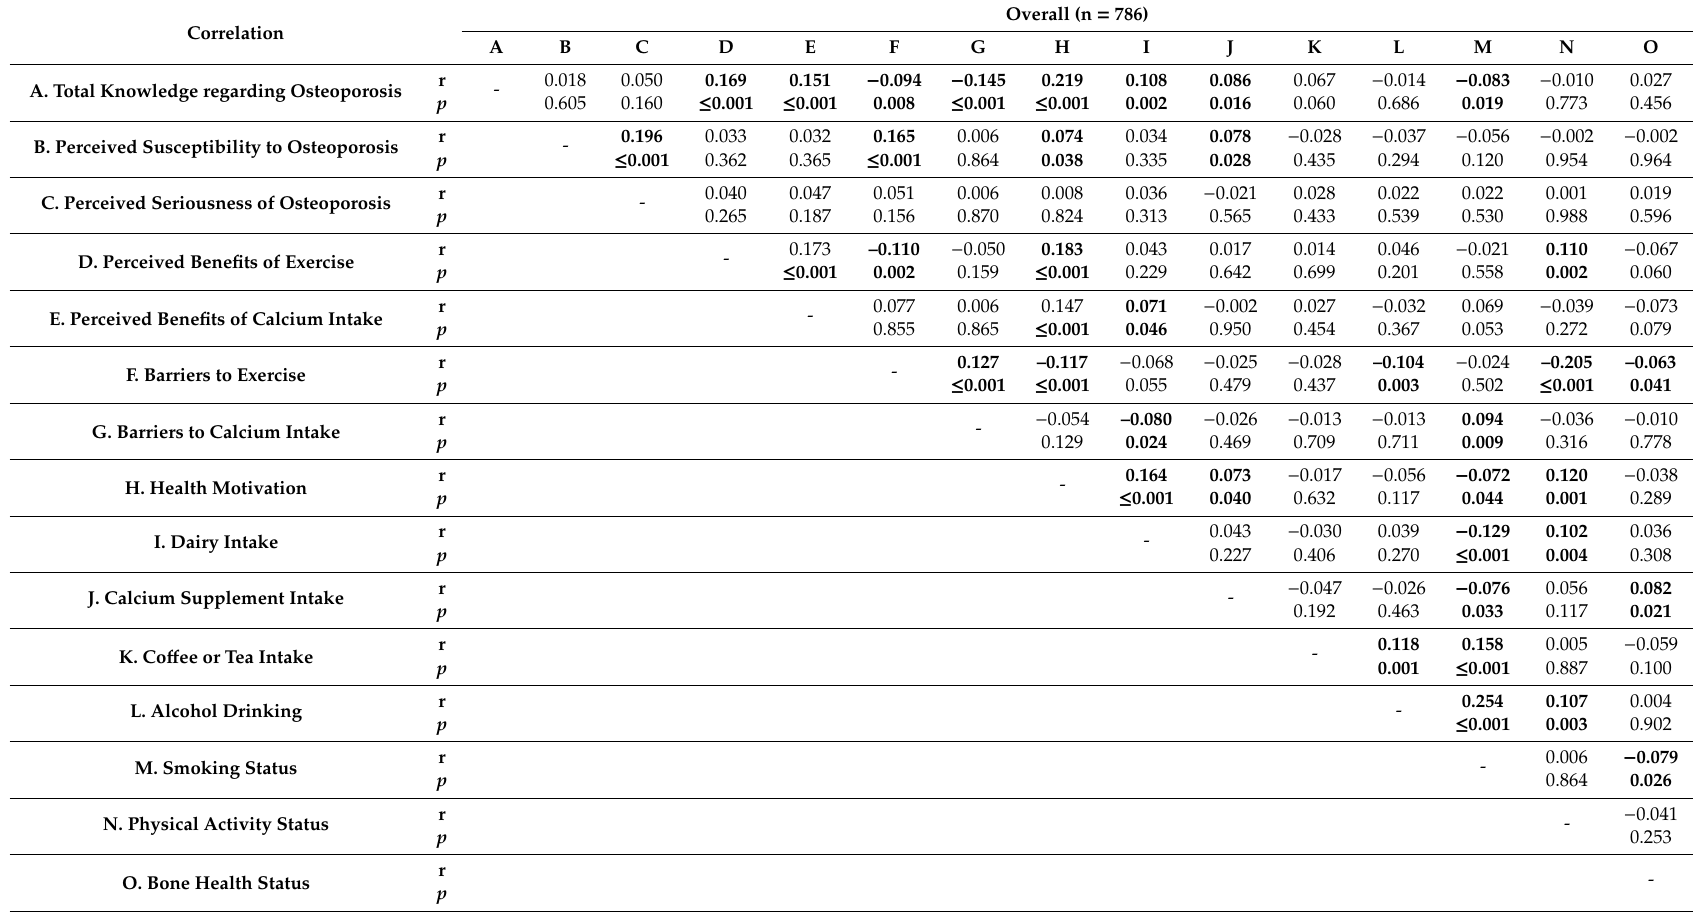
Table 5. Correlation between osteoporosis knowledge, health beliefs, osteoprotective practices, and bone health status (N = 786). Correlation